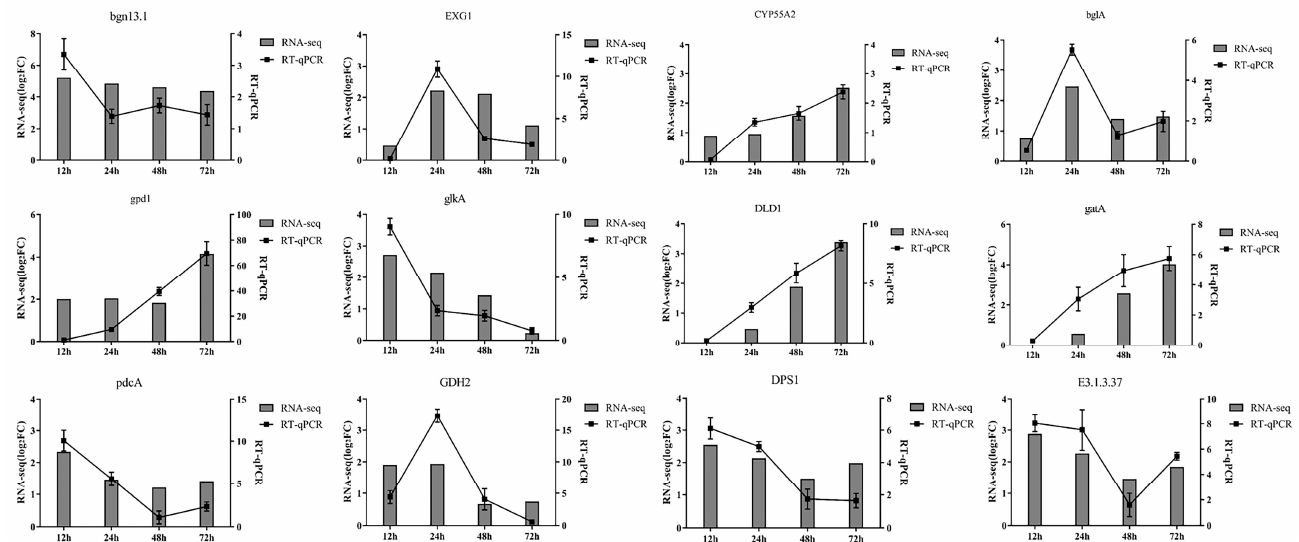
Figure 7. Comparison of RNA-Seq and real-time RT-PCR analysis. The relative expression levels of 12 single genes of T. harzianum T4 when treated with BCCW for different times (12, 24, 48 and 72 h) were compared with RNA-Seq in pairs. The histograms represent the relative expression level (log 2 FC) assessed by RNA-Seq. The black dotted lines indicate the relative expression level (2 −ΔΔ Ct ). The error bars represent the standard deviation of three duplicates.